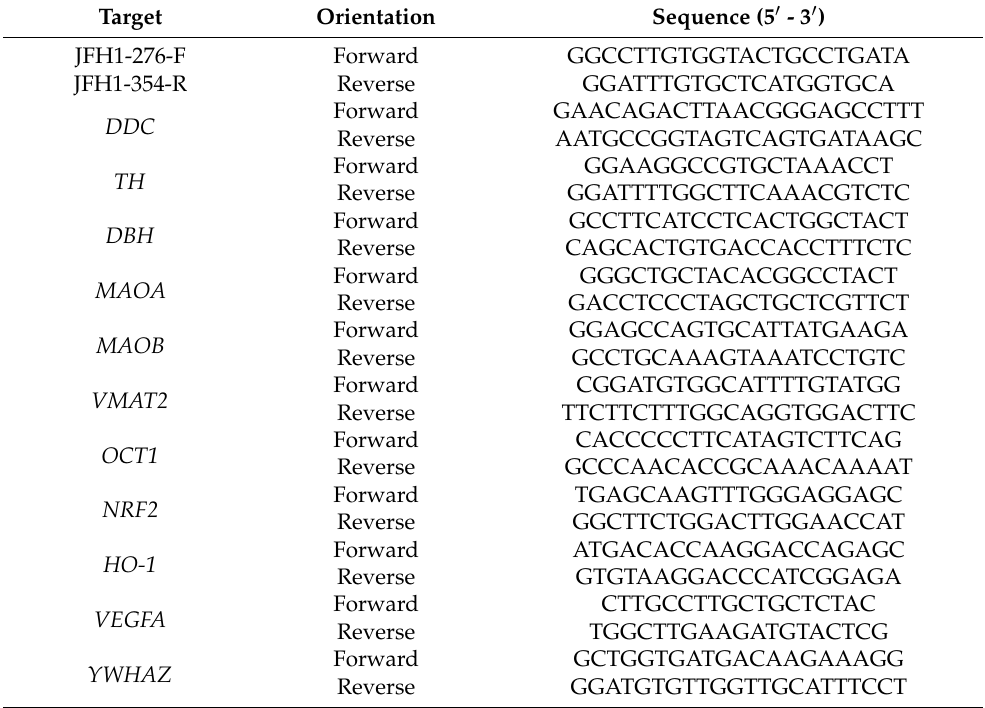
Table 1. Priming oligonucleotides used for RT-qPCR